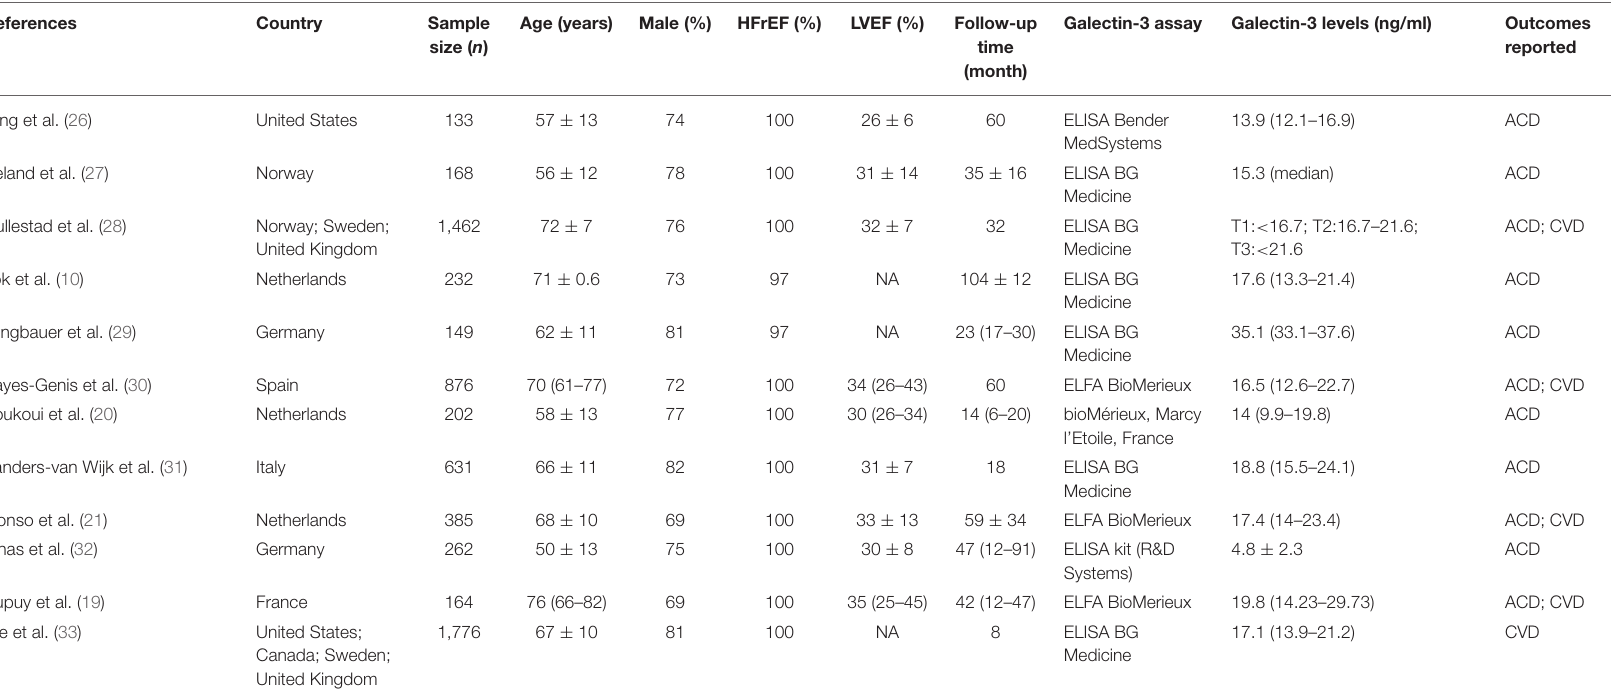
TABLE 1 | Characteristics of the studies included in